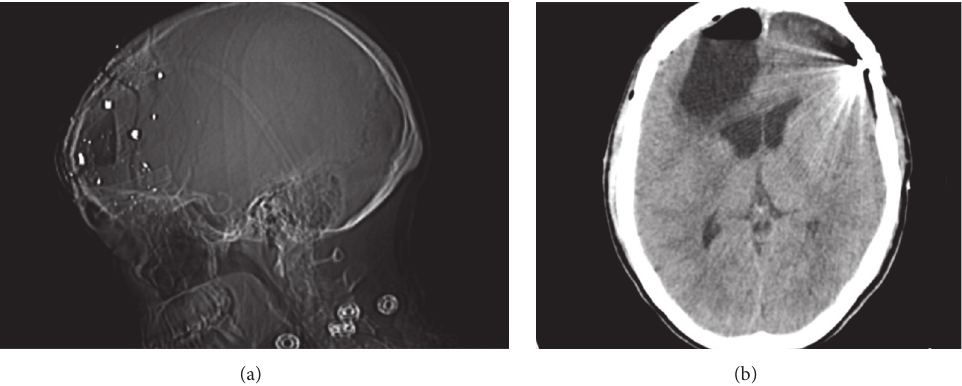
Figure 3: Postcranioplasty CT head. (a) Scout image showing reduction in size of pneumocephalus. (b) Axial noncontrast head CT demonstrates marked resolution of pneumocephalus and decreased midline shift and mass effect on the right lateral